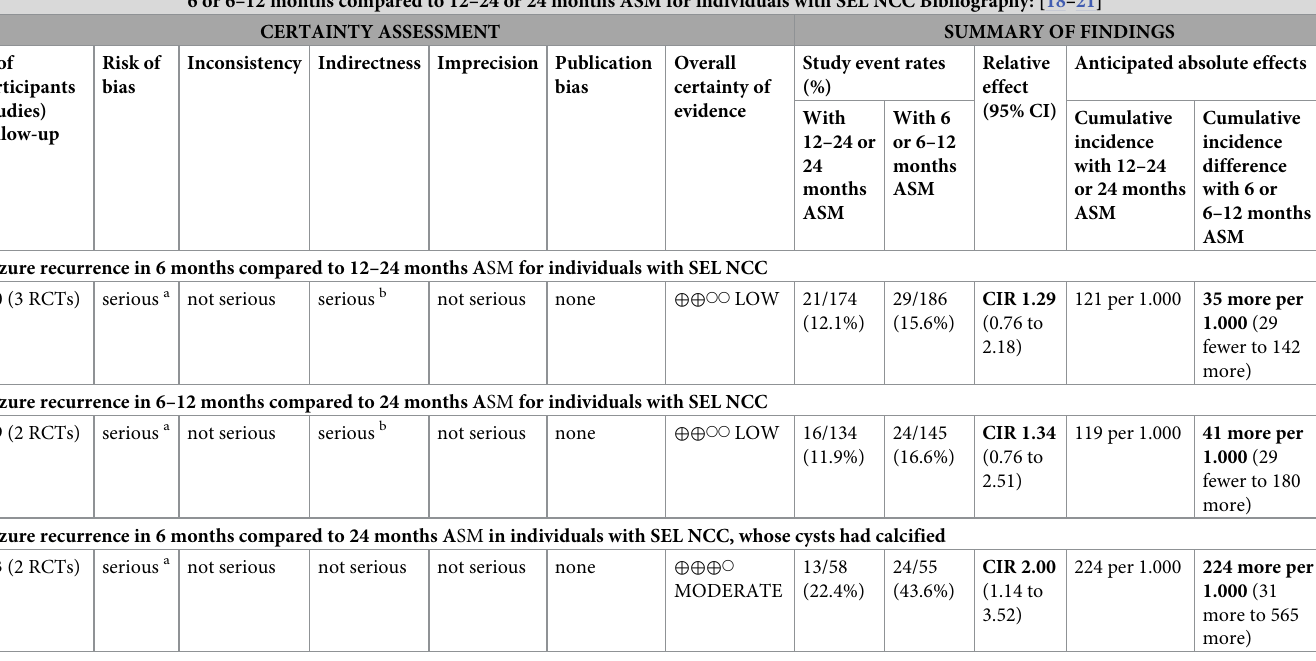
Table 2. GRADE table ASM.